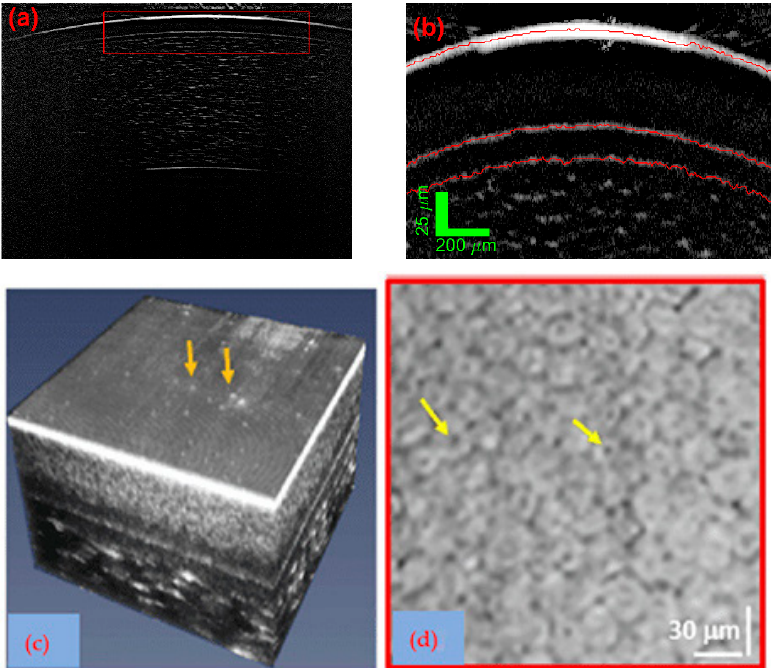
Figure 4. ( a , b ) Reproduced with permission from Ref. [56], in vivo image of the cornea with high axial resolution and high depth of field LF SD OCT system. ( a ) Averaged image. ( b ) Zoom on front of cornea with segmentations to measure Bowman’s and epithelial layers’ thickness. ( c , d ) Reproduced with permission from Ref. [92], in vivo imaging of the cornea with a high axial and lateral resolution LF SD OCT system. ( c ) Volume of front of the cornea. ( d ) En-face image of endothelium cell structure at the back of the cornea.